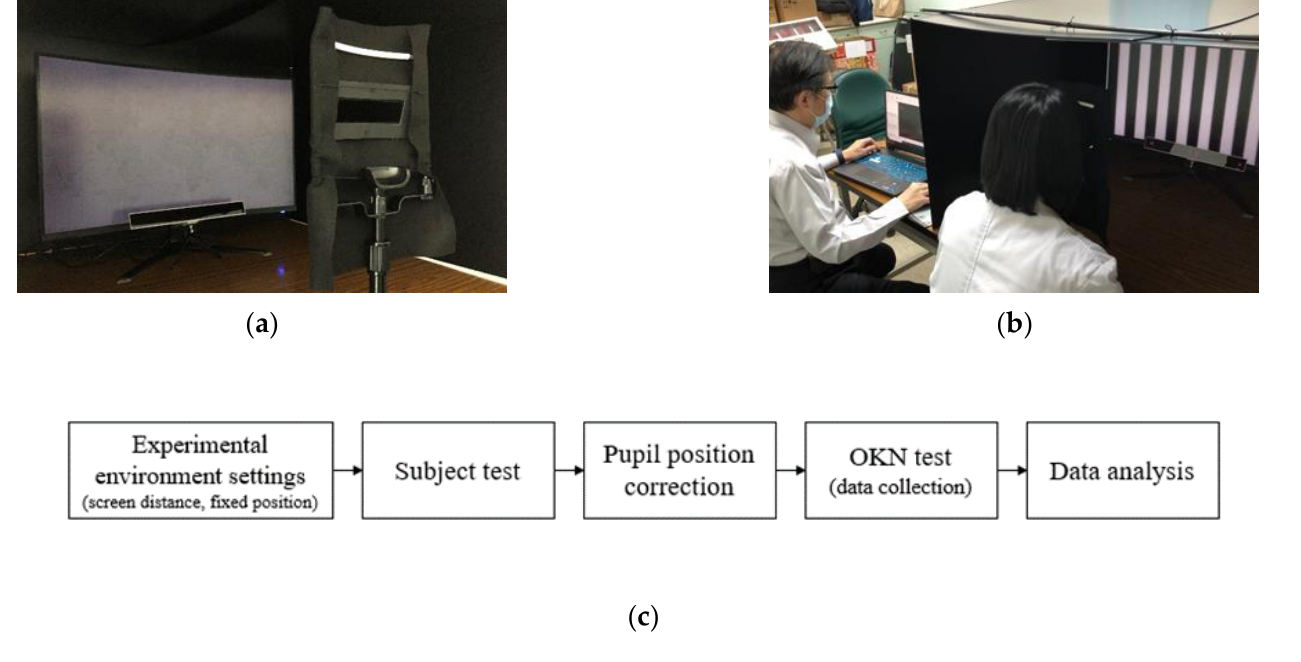
Figure 1. ( a ) Test environment for collecting OKN data. The eye tracker was placed beneath the screen. A chin rest was used to stabilize the subject’s head and a black facial shield was used to reduce noise signal during the test; ( b ) The screen displayed the dynamic OKN stimuli and the eye movement signal was captured by the eye tracker; ( c ) The experimental process.